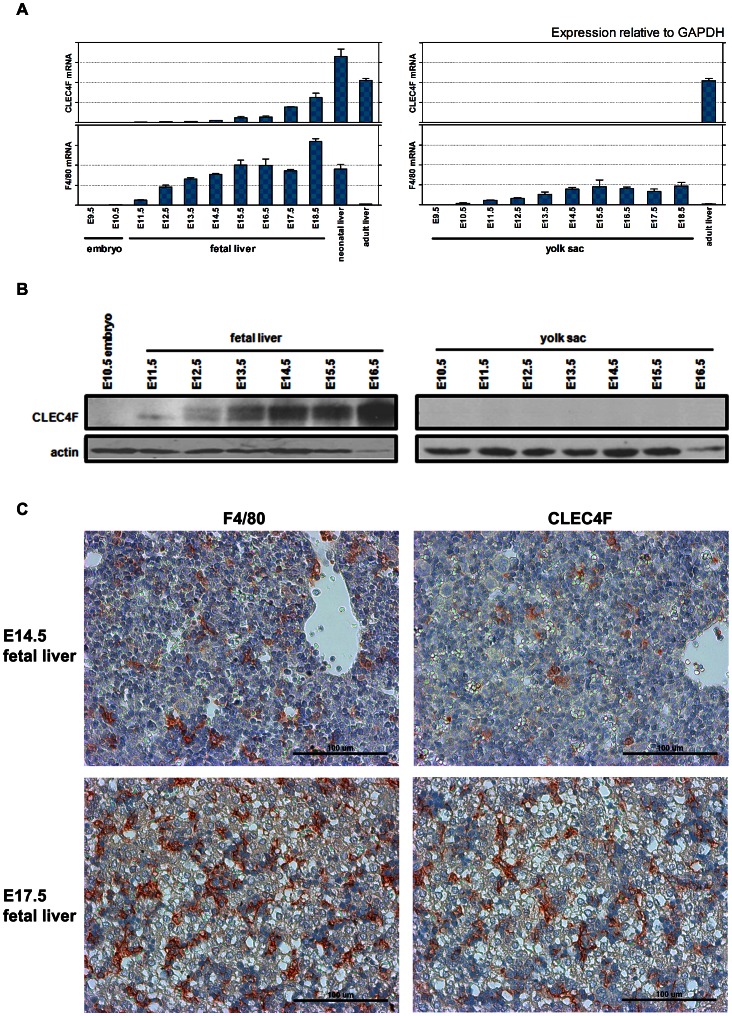
Expression of CLEC4F during embryogenesis.Yolk sac, embryo and fetal liver in various embryonic stages were collected for CLEC4F detection by (A) qRT-PCR and (B) Western blot. Actin was used as internal control. (C) F4/80 and CLEC4F immunohistochemistry of fetal liver from E14.5 and E17.5, respectively.